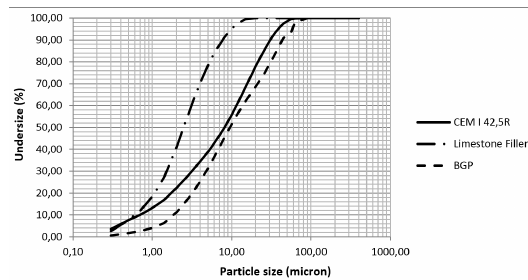
Figure 1. Particle size distribution of cement, glass powder and limestone filler.